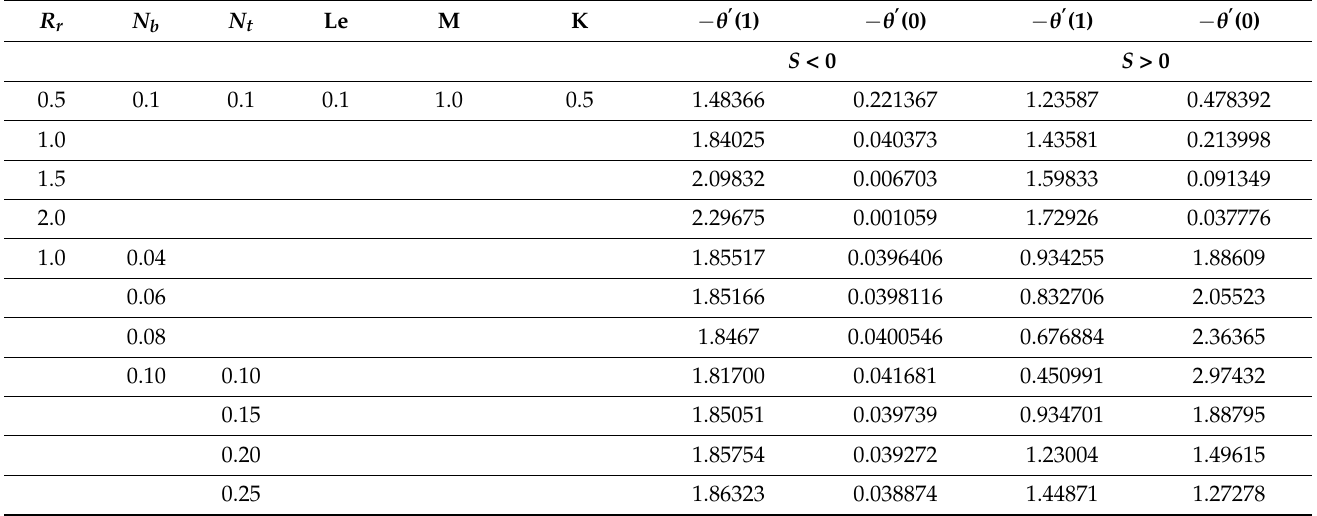
Table 7. Local Nusselt number for γ Al 2 O 3 − H 2 O at lower and upper plane with weak interaction n =